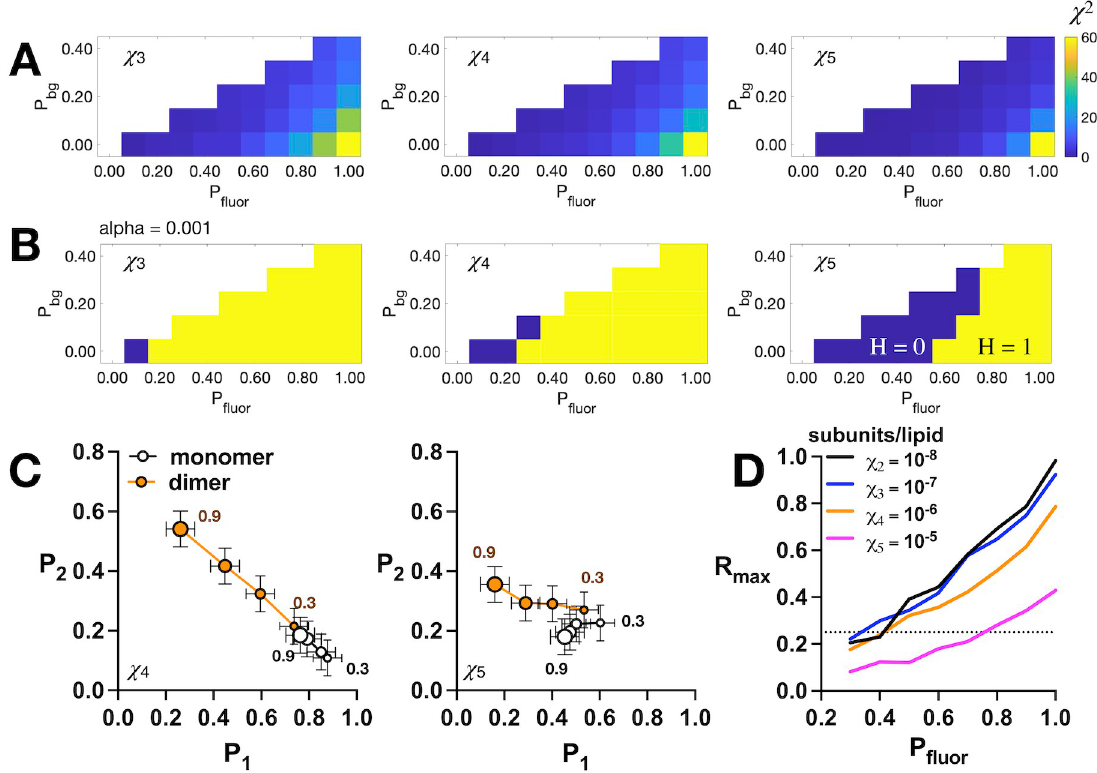
Fig 5. The operational range for fluorophore labeling yields. (A) Chi-squared ( χ 2 ) analysis between monomer and dimer model photobleaching probability distributions over ( P , P ) fluorophore labeling parameter space for P < P = P — P . χ 2 heatmaps are fluor bg bg site fluor bg shown for mole fraction densities χ 3 = 2 x 10 − 7 , χ 4 = 2 x 10 − 6 , χ 5 = 2 x 10 − 5 subunits/lipid. (B) Heatmaps of null hypothesis testing for the χ 2 values in (A) for alpha = 0.001 significance. The null hypothesis is that the monomer and dimer distributions are the same, where H = 1 (yellow) indicates a rejection of the null hypothesis, and H = 0 (purple) indicates that the null hypothesis cannot be rejected at the indicated significance level. (C) P vs. P for monomer (white) and dimer (orange) models for P = 0.3 to 0.9 and P = 0.1. Symbol size increases 1 2 fluor bg with increasing P fluor with endpoints labelled as shown. Error bars depict representative standard deviation values of the experimental data for RCLC, std = ± 0.06. (D) Maximal scalar distance, R , between (P , P signals from monomer and dimer model distributions as a max 1 2 ) function of mole fraction density. The background labeling yield is set to P = 0.1. The dotted line indicates R = 0.25 that corresponds bg max to the significance testing cutoff in the χ 2 analysis in